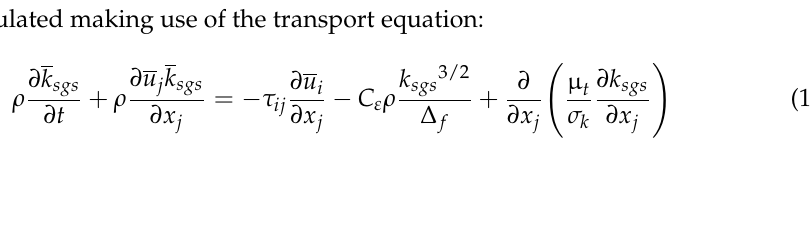
. s i = W i c i B i T α i exp ( − E i / RT ) in kg/m 2 /s. ( a )